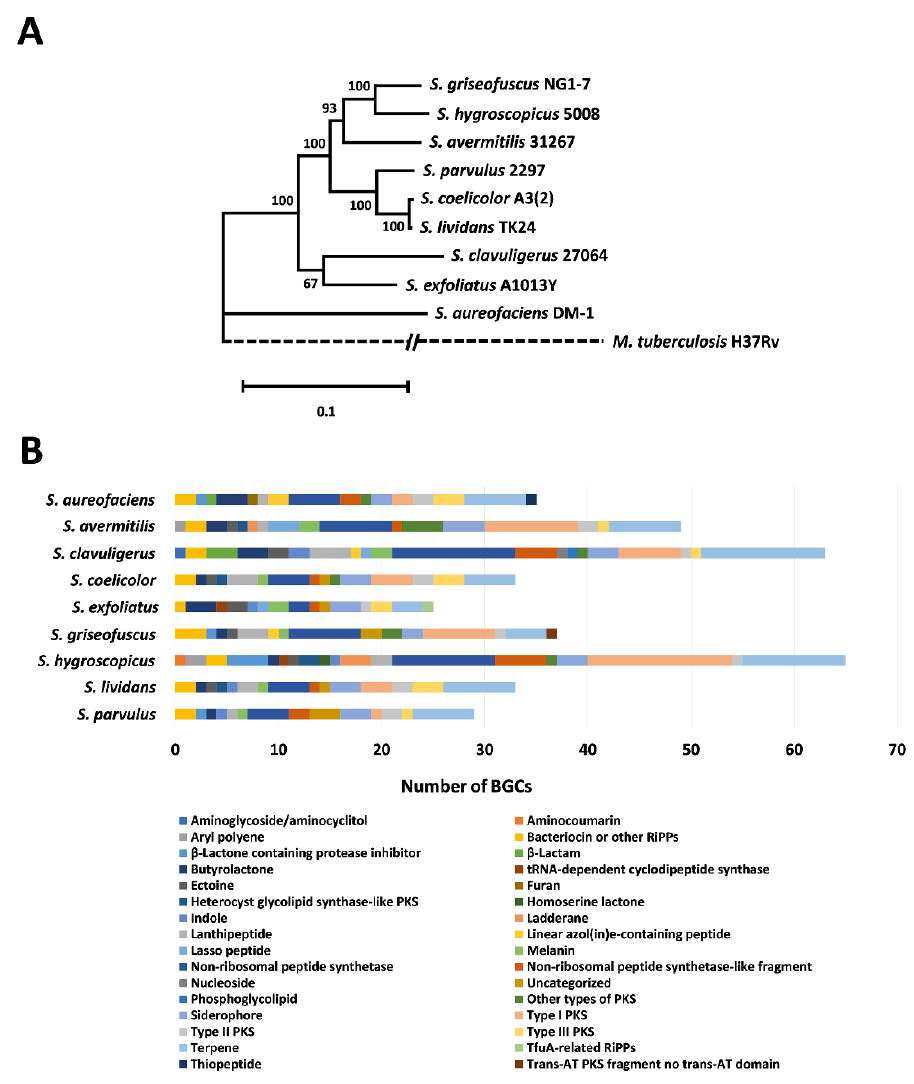
Figure 1. Relative phylogeny and BGC content of Streptomyces spp. used in the current study. ( A ) Maximum likelihood tree of the respective Streptomyces spp. based on five concatenated housekeeping genes: atpD , gyrB , recA , rpoB and trpD . Bootstrap values were calculated using 100 replicates and Mycobacterium tuberculosis served as an outgroup. The percentage of trees in which the species clustered together is shown next to the branches. The tree is drawn to scale, with branch lengths measured in the number of substitutions per site. ( B ) Predicted BGC numbers and their respective classes (listed below) as per antiSMASH.